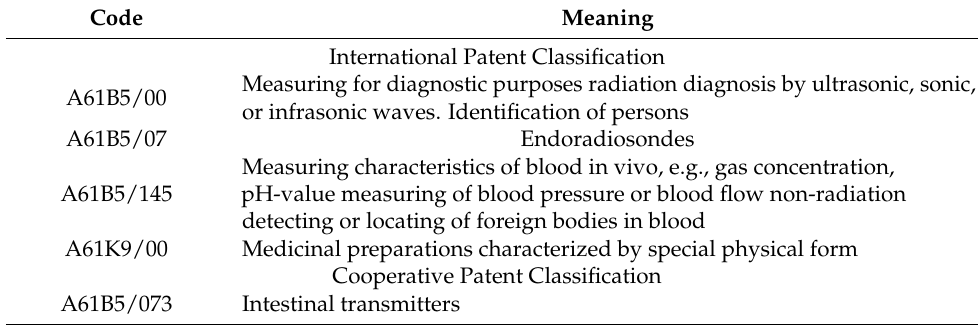
Table 2. The International Patent Classification and Cooperative Patent Classification codes are used in the patent